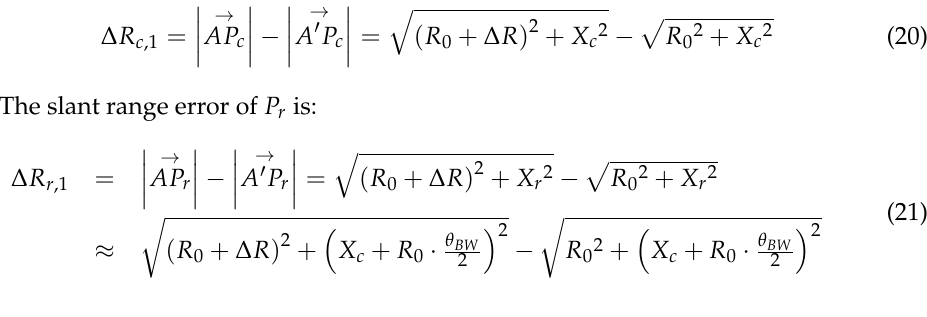
'' A are the platform